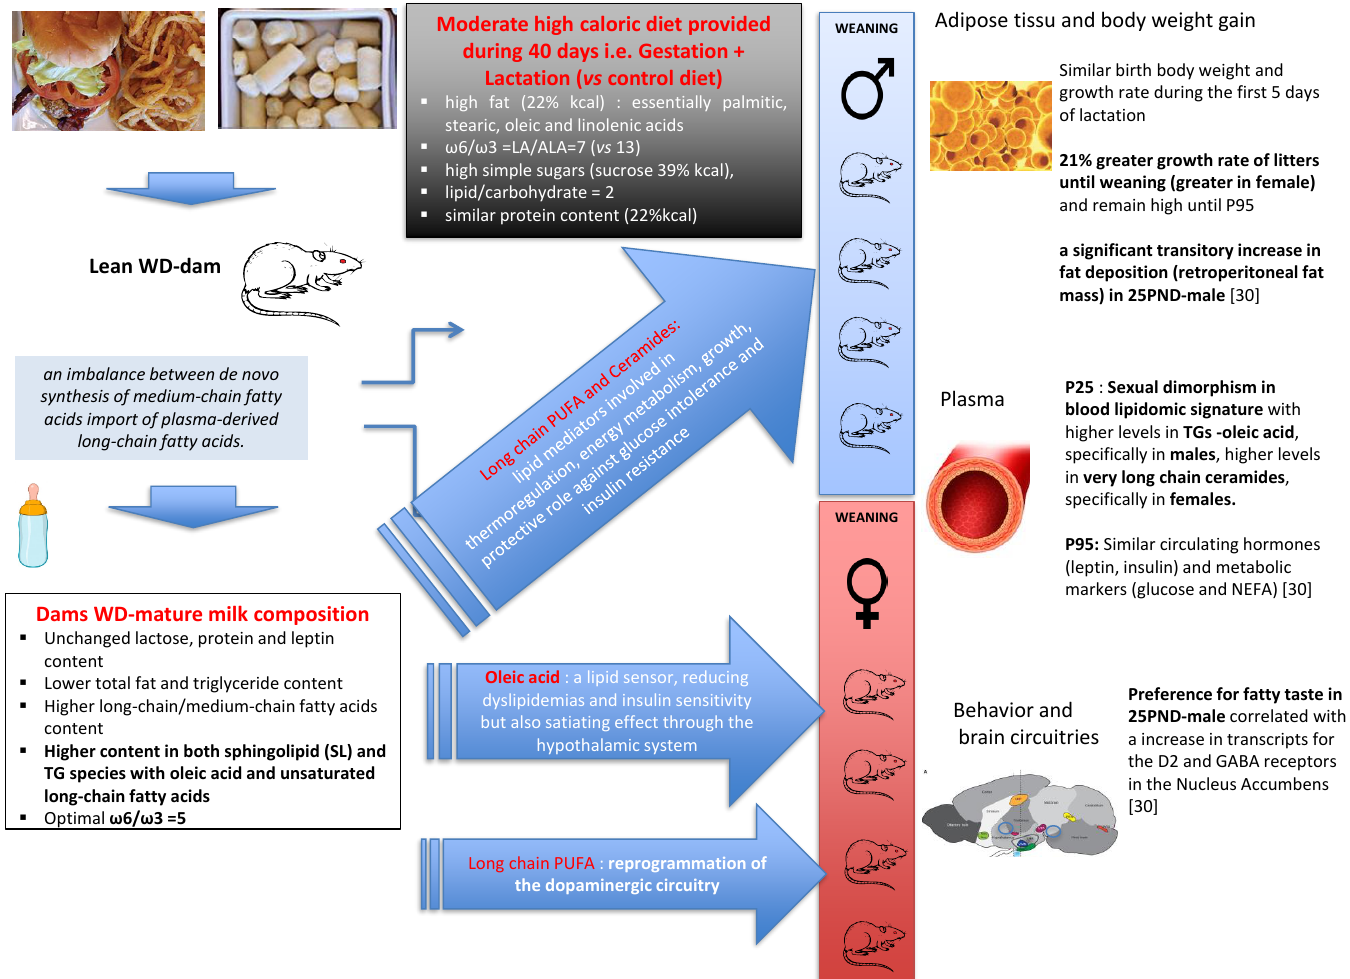
Figure 7. Putative mechanisms mediating the e ff ects of moderate high caloric diet during gestation and lactation on mature breast milk composition and o ff spring blood lipidome and phenotype at weaning and at